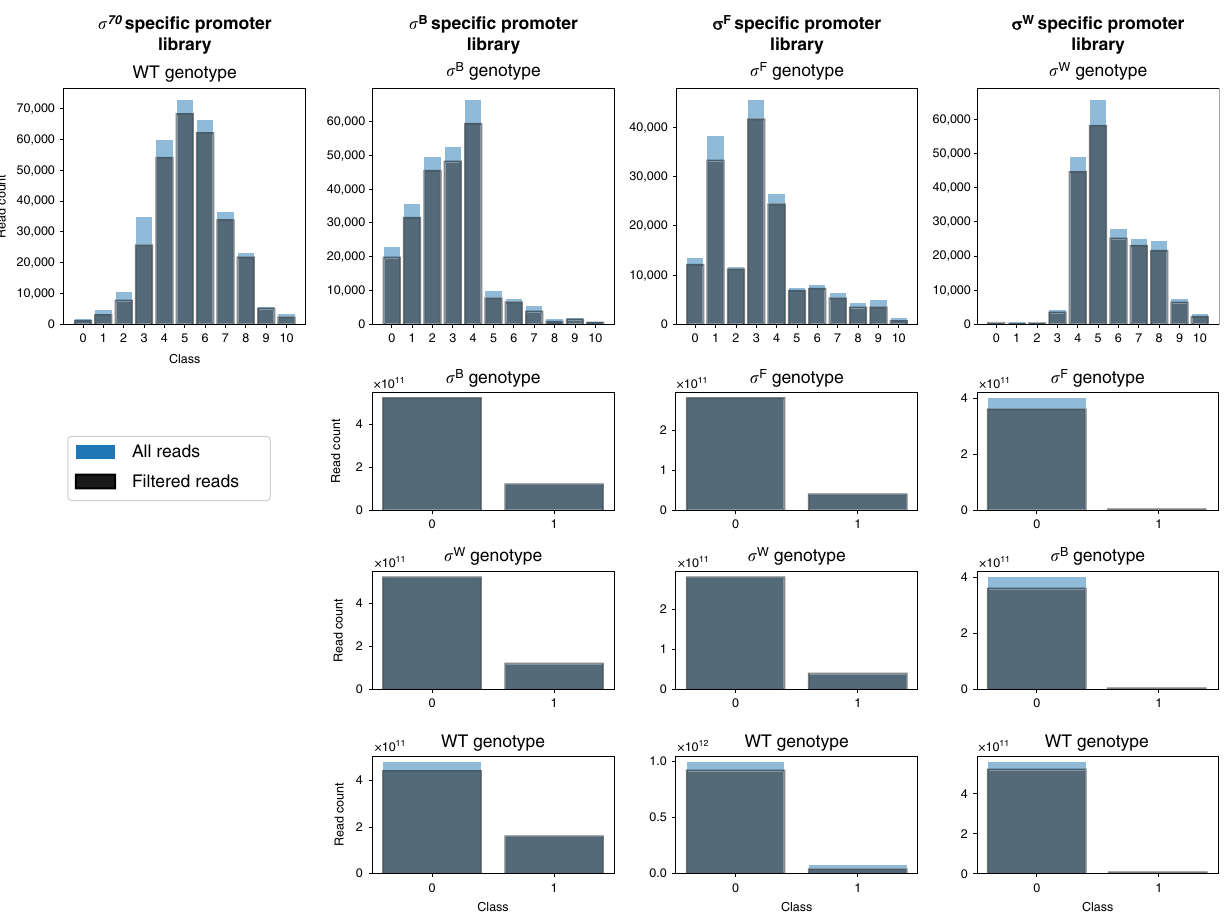
Fig. 2 An overview of the data available for each setting in relation to the labeled sequences used for the prediction task. For each setting is given: the total number of sequences and the part used for model training after exclusion of the outliers. For each promoter library the genotypic background is given: heterologous sigma factors ( σ ) B, F, or W from Bacillus subtilis expressed in Escherichia coli ( E. coli ), or wild-type (WT) E. coli harboring no heterologous sigma factors. For the binary setting, the positive class represents fl uorescence, indicating the loss of orthogonality. An overview of the data samples for each setting is listed in Supplementary Table 1. Source data are provided as a Source Data fi